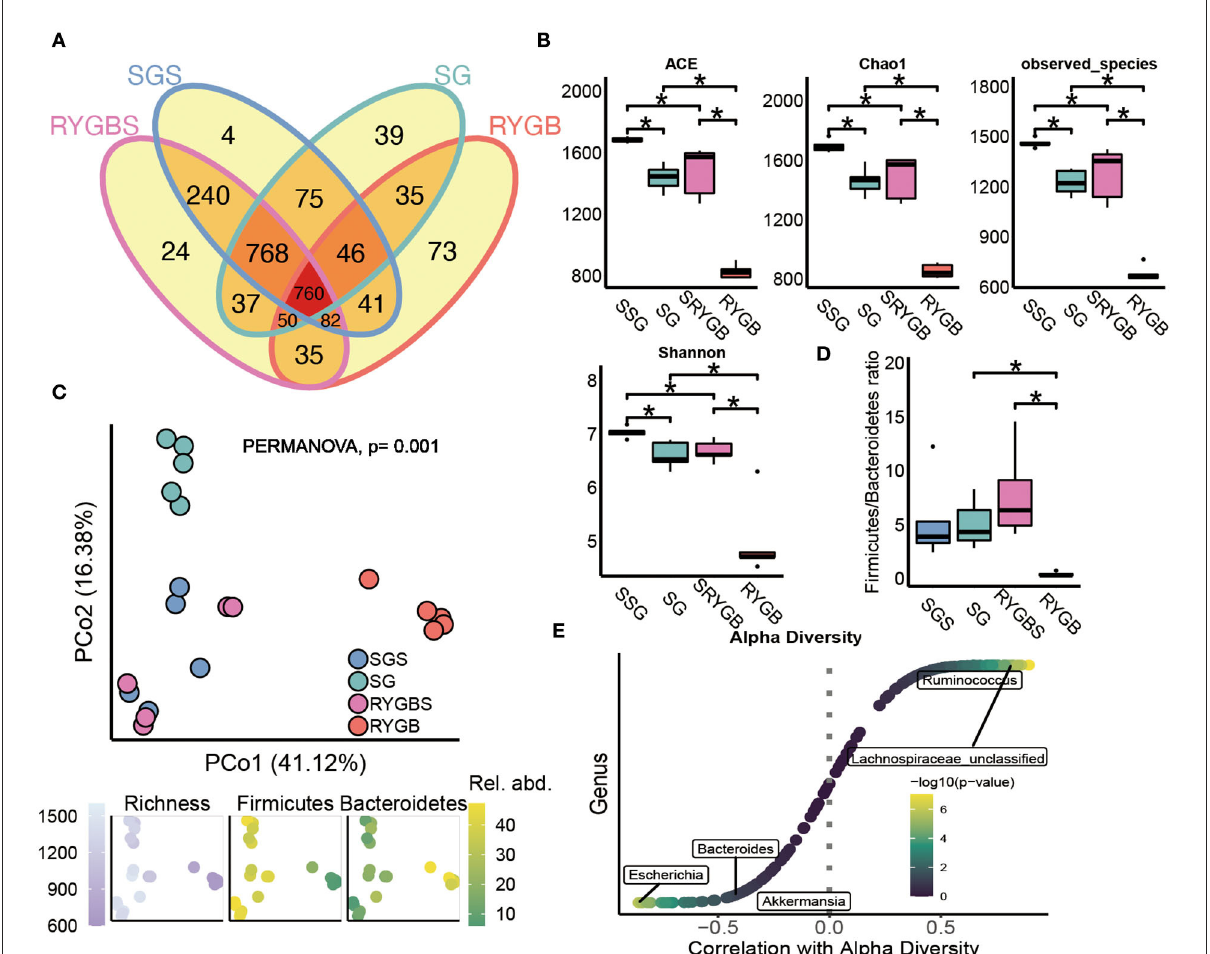
FIGURE1 The altered fecal microbiota of SG and RYGB surgeries. (A) The shared and unique observed OTUs in four groups. (B) The alpha diversity difference among groups. (C) PCoA reveals a clear distinct difference in gut microbiota in four groups. (D) The comparison of phylum Firmicutes / Bacteroidetes ratio in four group individuals. (E) The correlation between alpha diversity and alerted gut microbiome. * P < 0.05, Kruskal–Wallis test with post-hoc Dunn’s